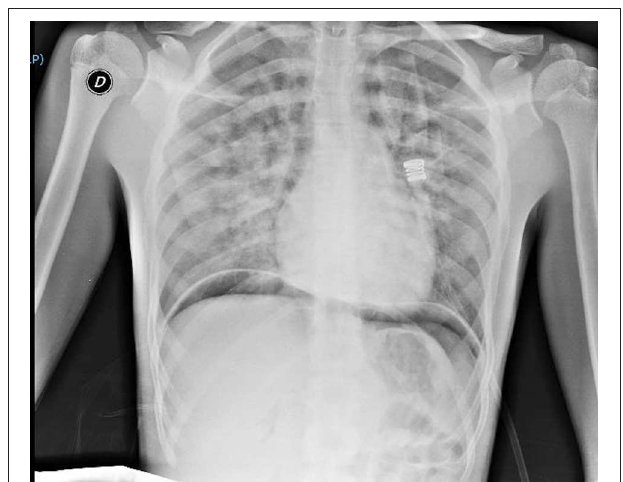
FIGURE 1 | Chest x-ray at clinical onset of symptoms, consistent with diffuse alveolar hemorrhage (DAH). There can be observed infiltrative opacification pattern mainly seen in the mid zones with apical sparing suggestive for impaired pulmonary microcirculation. There can be noticed areas of subdiaphragmatic air due to laparoscopy.